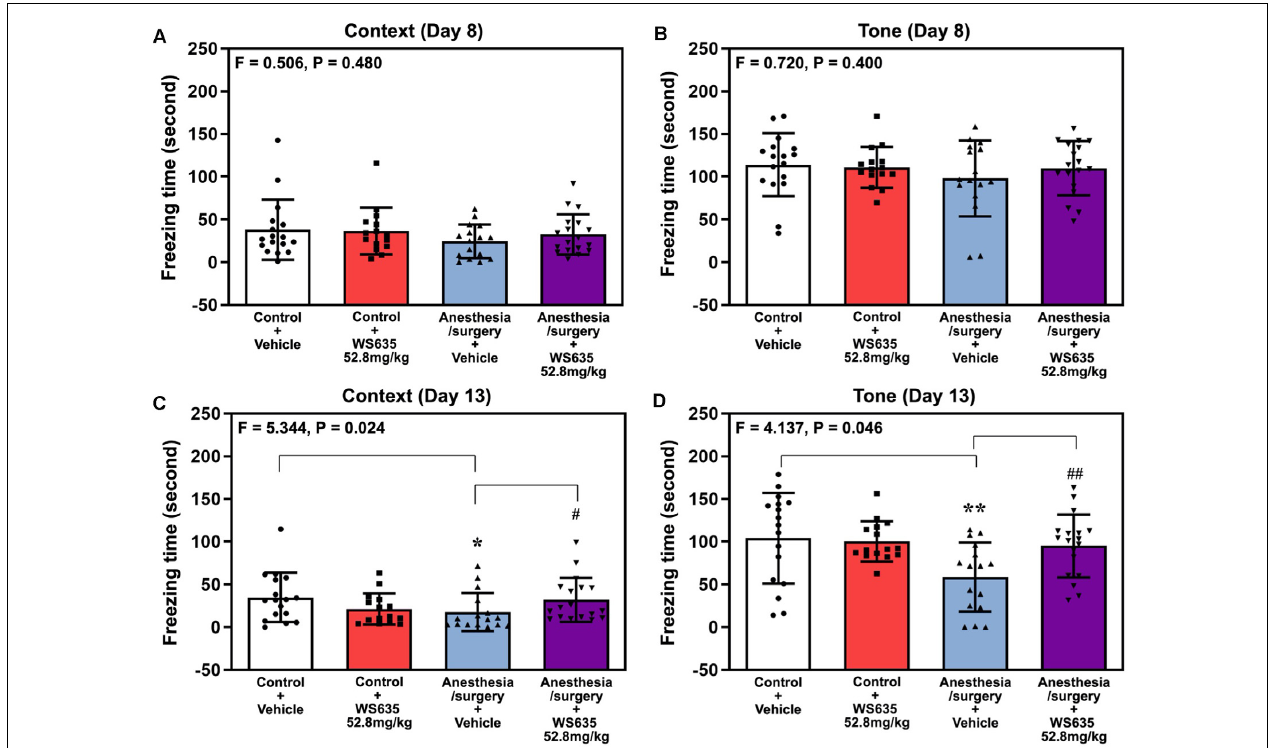
FIGURE 5 | Effects of WS635 on the anesthesia/surgery-induced changes in the cognitive function in mice detected in fear conditioning system (FCS). Effects of WS365 (52.8 mg/kg) and vehicle (DMSO) on the anesthesia/surgery-induced changes in the freezing time on the context (A) and tone (B) test of FCS on 8 days after the anesthesia/surgery; and on the context (C) and tone (D) test of FCS on 13 days after the anesthesia/surgery. N = 14–18 mice in each group. Two-way ANOVA with the post hoc Bonferroni correction was used. * or # P < 0.05; ** or ## P < 0.01. P values refer to the difference among different conditions on the freezing time of the FCS. DMSO, dimethyl sulfoxide; FCS, fear conditioning